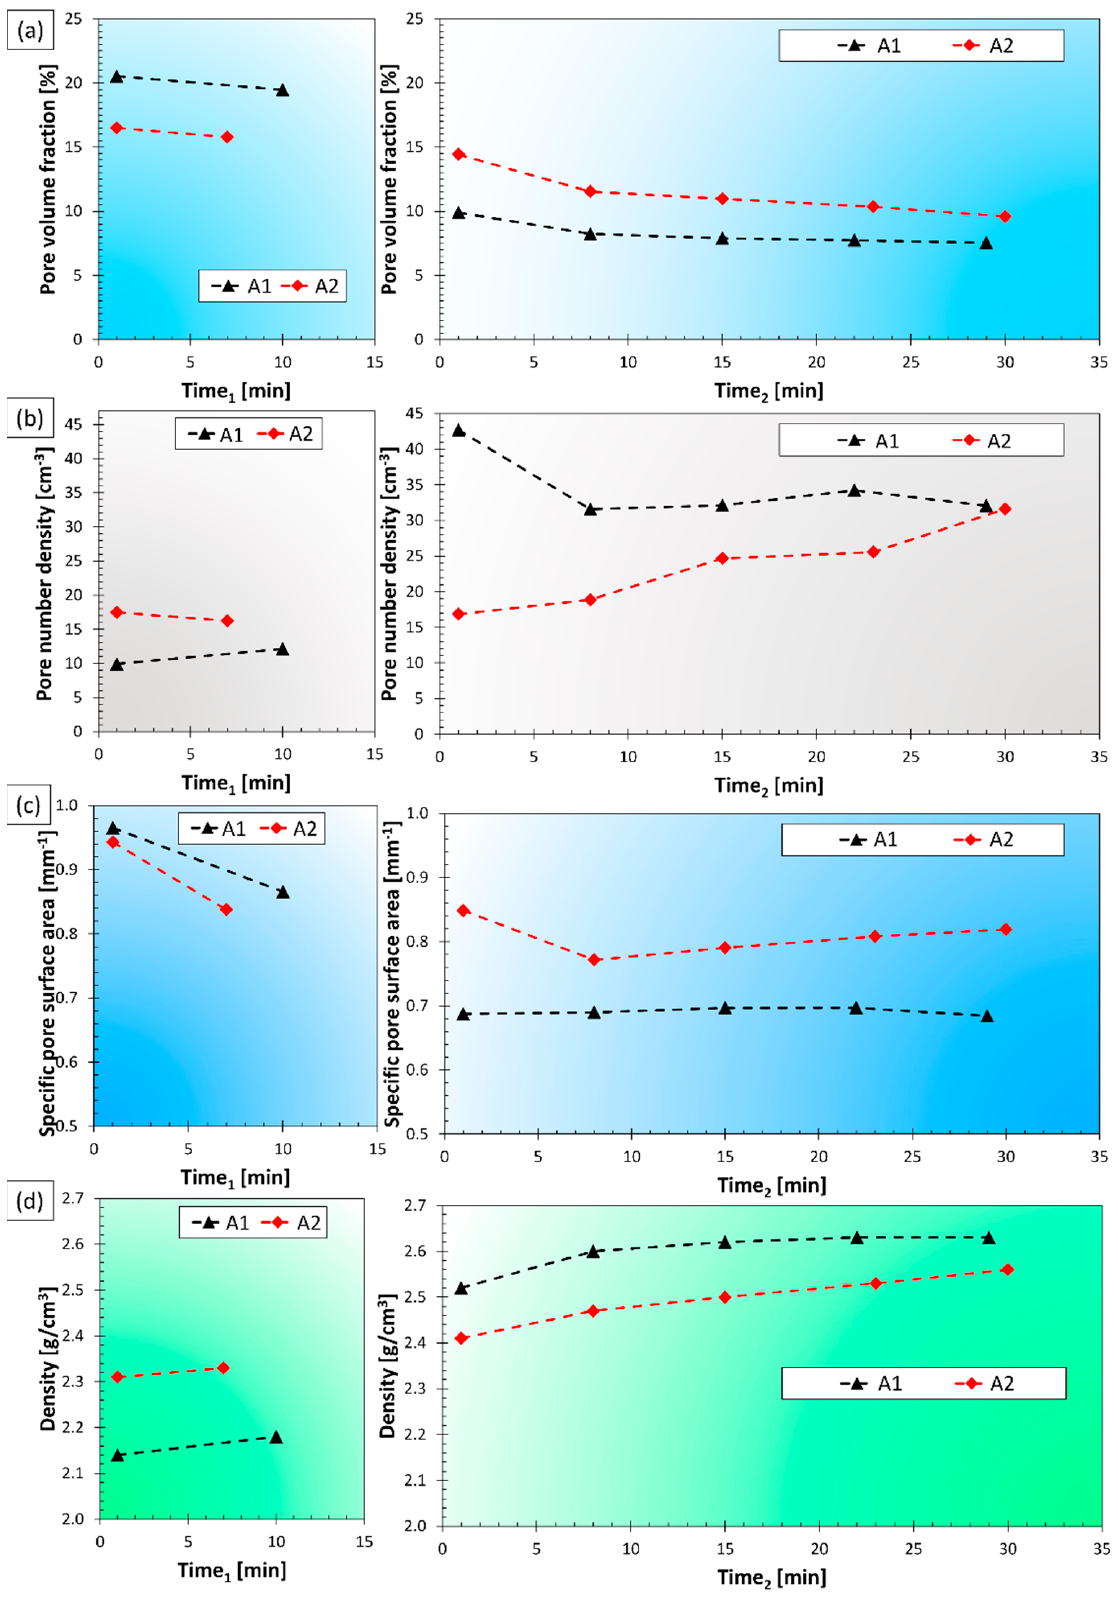
Figure 15. ( a ) Pore volume fraction, ( b ) pore number density, ( c ) specific pore surface area, and ( d ) density results.